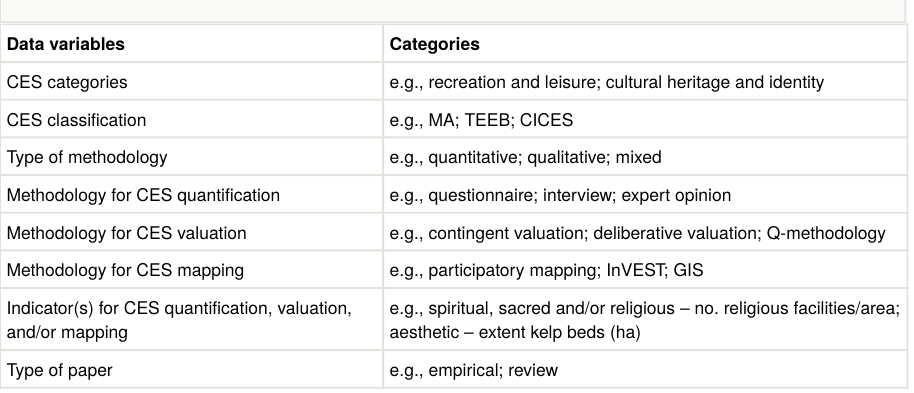
The systematic review data included 20 variables and their corresponding response categories (Table 1). Data variables included CES classes assessed; quanti fi cation, valuation, and/or mapping methodologies; synergies and trade-o ff s identi fi ed; links between habitats, CES, and human wellbeing; countries of case studies; drivers of change a ff ecting ecosystems and their CES; and others. Table 1. Data variables and corresponding categories used to collect data in the systematic literature